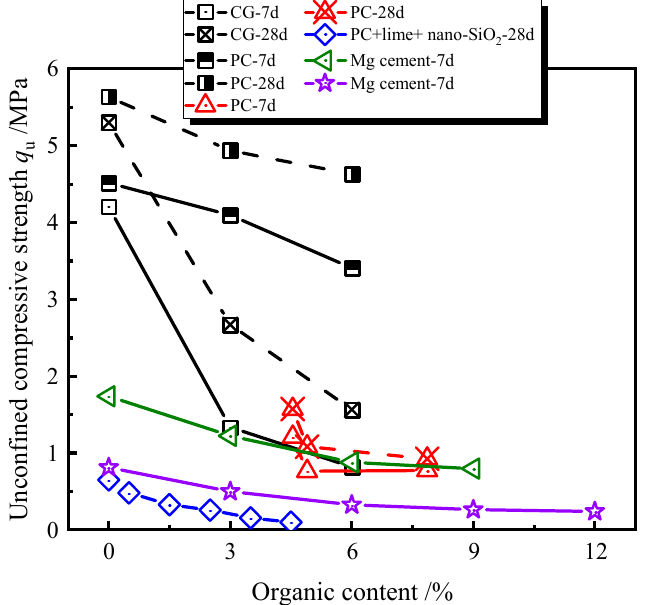
Figure 9. Strength of cement-based materials for treating organic-rich soils under different condi- tions [26, 30–32]. Table 5. Comparison of different conditions for treating organic-rich soils.